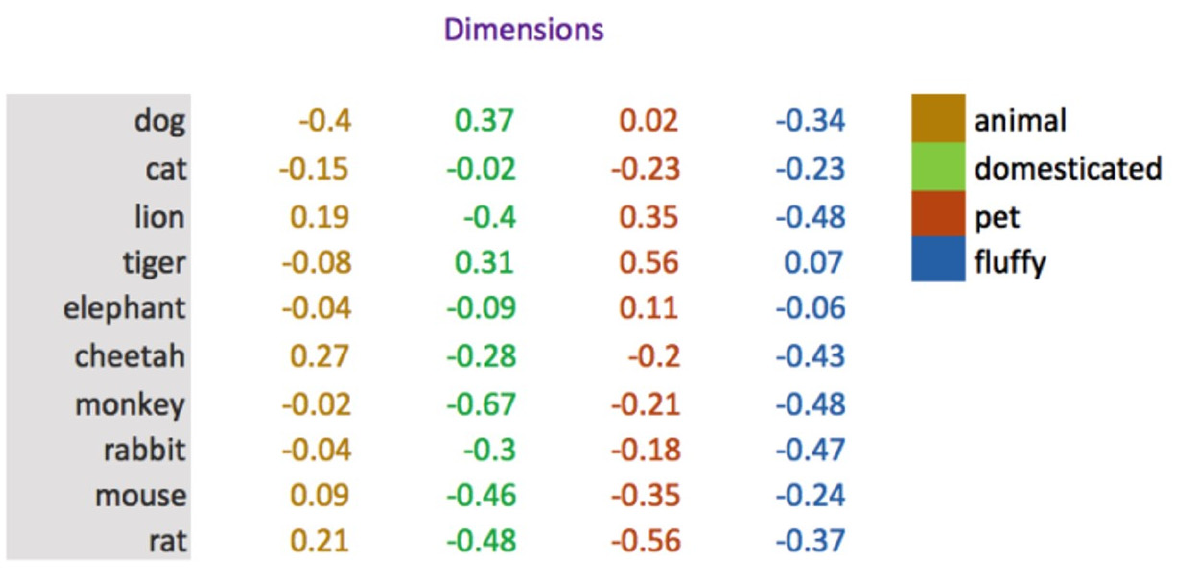
Figure 2. Simplified representation of word vectors. Jayesh Bapu Ahire. Introduction to Word Vec- tors. Available on: https://dzone.com/articles/introduction-to-word-vectors (accessed on 28 July 2022).